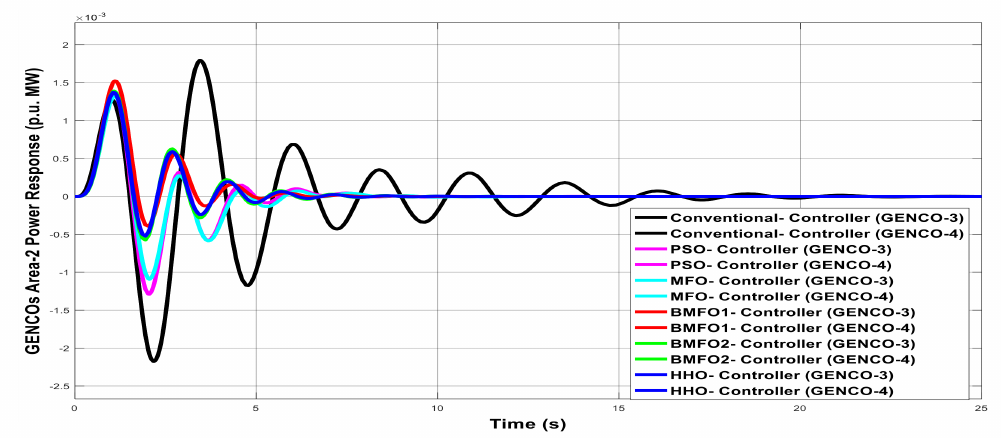
Figure 8. GENCOs generation response of Area2 with various controllers under unilateral contract.